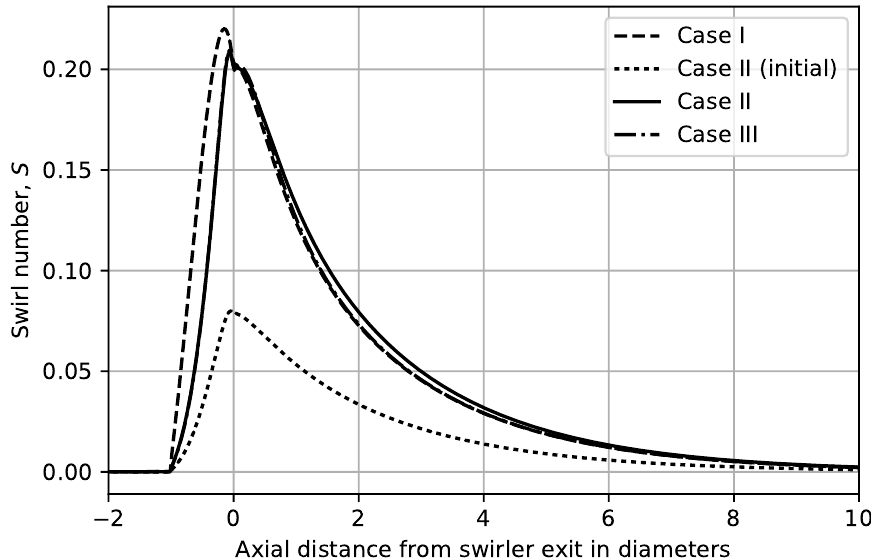
Figure 13. Decay in swirl number along the pipe axis (number of diameters downstream of end of the swirler). In the (initial) case, the twist angle is set to 30 ◦ , which corresponds to the theoretical deviation angle for S = 0.2.